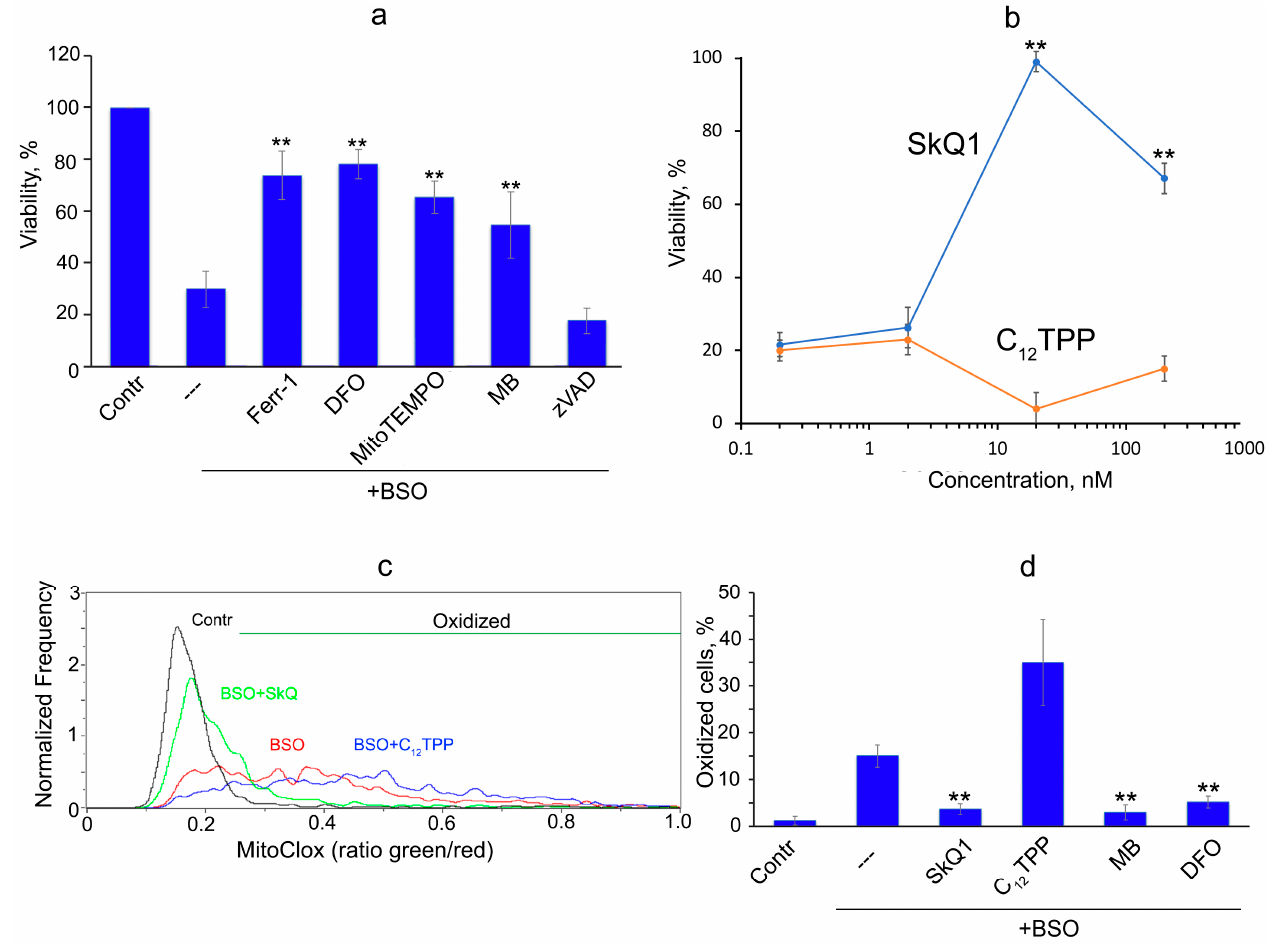
Figure 2. SkQ1 and methylene blue inhibit ferroptosis induced by butionine sulfoximine in fibroblasts from patient with Leber’s hereditary optic neuropathy (LHON). Fibroblasts were treated with butionine sulfoximine (BSO, 1 mM) for 24 h. Viability was analyzed using CellTiterBlue ® test. Peroxidation of mitochondrial lipids in fibroblasts was measured with MitoCLox as described in Methods. ( a ) DFO, Fer-1, MitoTEMPO, and MB (concentrations as in Figure 1a), as well as zVADfmk (10 µ M), were added together with BSO. ( b ) SkQ1 and C 12 TPP were added together with BSO. ( c , d ) Results of MitoCLox oxidation analysis using flow cytometry. Green and red fluorescence were measured simultaneously, and an increase in the green/red ratio indicates oxidation of MitoCLox. Cell fractions with oxidized MitoCLox calculated as shown in ( c ) were measured in three independent experiments ( d ). BSO (1 mM), DFO, MB, SkQ1 (100 nM), and C 12 TPP (100 nM) were added for 17 h. **- p < 0.001